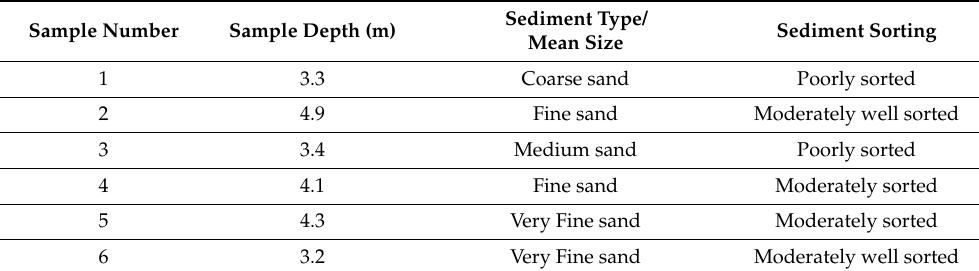
Figure 5. Side scan sonar mosaic map of the study area showing the traces of the submerged ancient harbor. ( a ) Very-coarse boulders; ( b ) Coarse boulders; ( c ) Buried archaeological remains; ( d ) Outcropping reefs. Table 1. Results of mean size and sorting of sediments